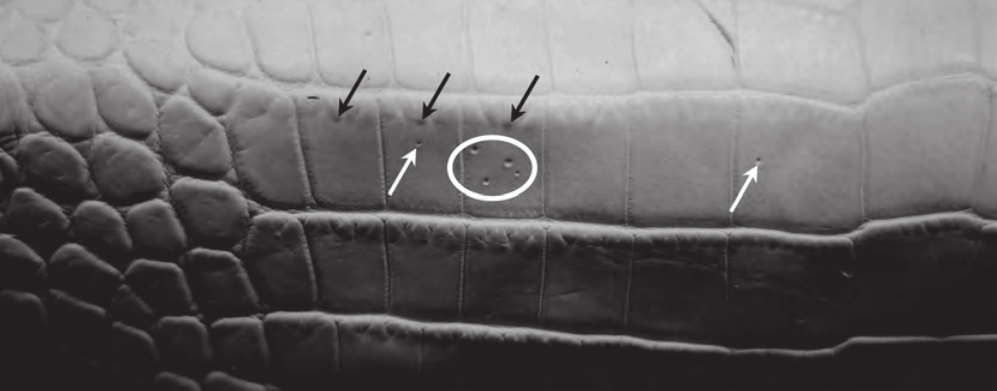
FIG. 4 Intracytoplasmic inclusions in the proliferating epider- mal cells in a newly formed cyst, indicated by the ar- rows, 10X FIG. 5 An early stage of a newly forming cyst with intracyto- plasmic inclusion bodies. F is a fold artefact induced by